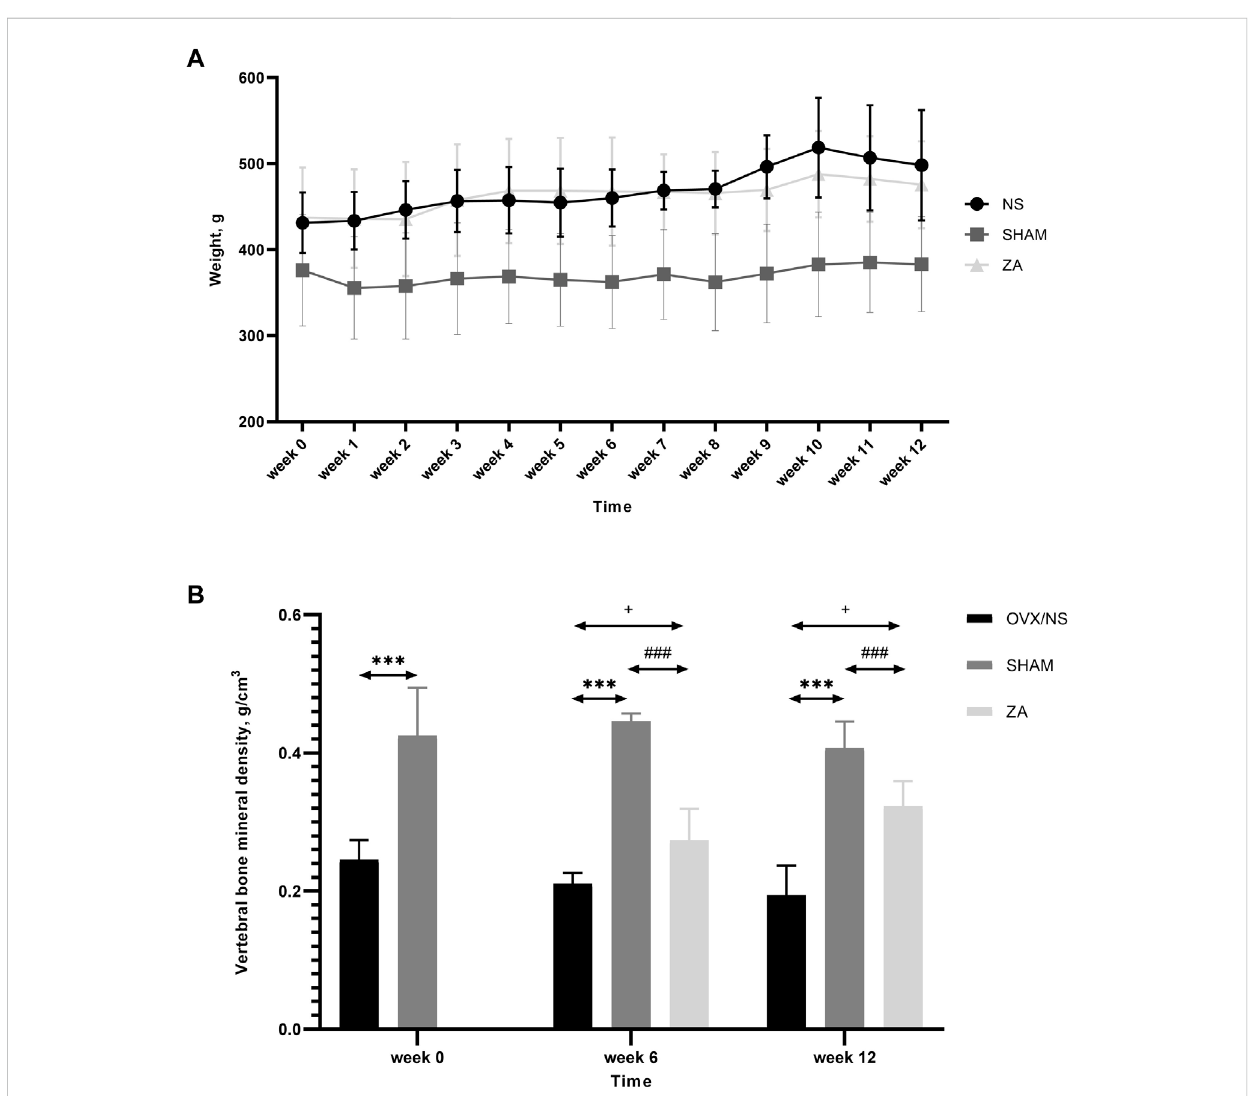
Bodyweightsandvolumetricbonemineraldensity(vBMD)ofthesecondlumbar(L2)vertebrae. (A) Bodyweightsofratsatdifferenttimepoints.Each value is expressed as the mean ± SD. Signi fi cant differences were observed in the SHAM versus NS and ZA groups at every time point, but no differences were observed between NS and ZA groups (determined using two-way ANOVA). (B) vBMD of L2 vertebrae. *** p < 0.001 SHAM versus NS; ### p < 0.001 SHAM versus ZA;+ < 0.05 ZA versus